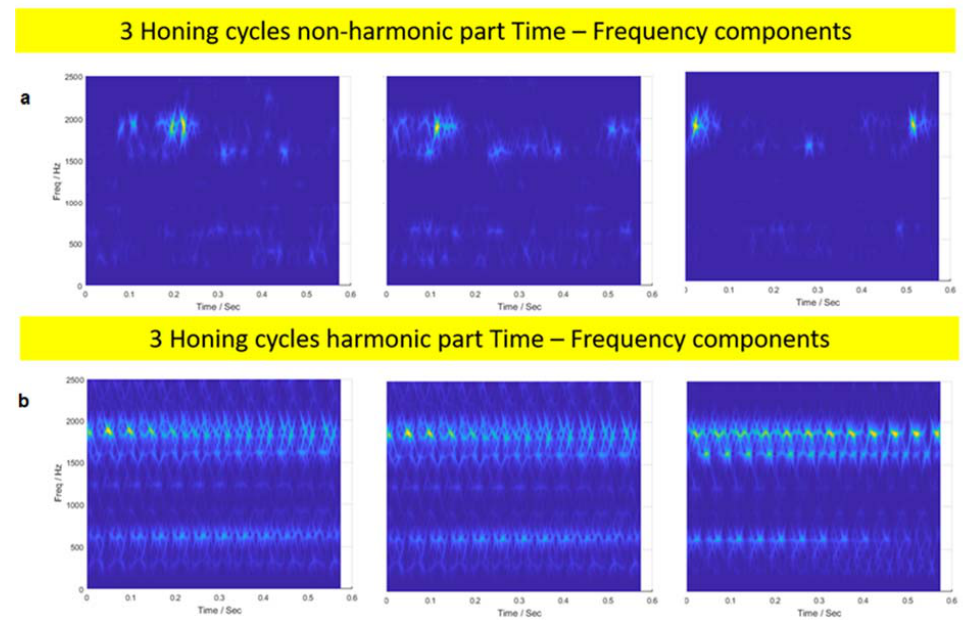
Figure 8. Chirplet time-frequency representation for 3 honing cycles of experiment 2: ( a ) Non-harmonic part and ( b ) harmonic part.